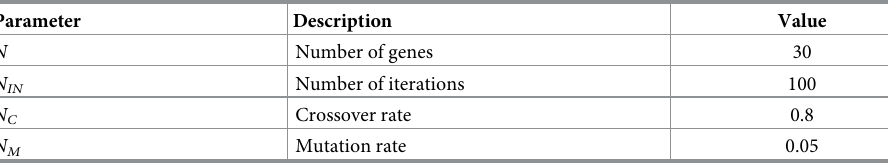
Table 2. GA parameters.